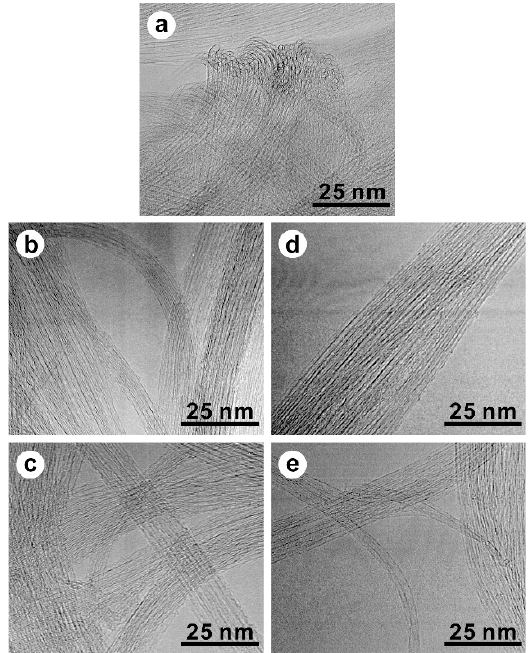
Figure 4. High-resolution transmission electron microscopy (HRTEM) images of the ( a ) P-SWCNTs, ( b ) F-RT-3m, ( c ) F-RT-4h, ( d ) deF-RT-3m, and ( e ) deF-RT-4h samples.